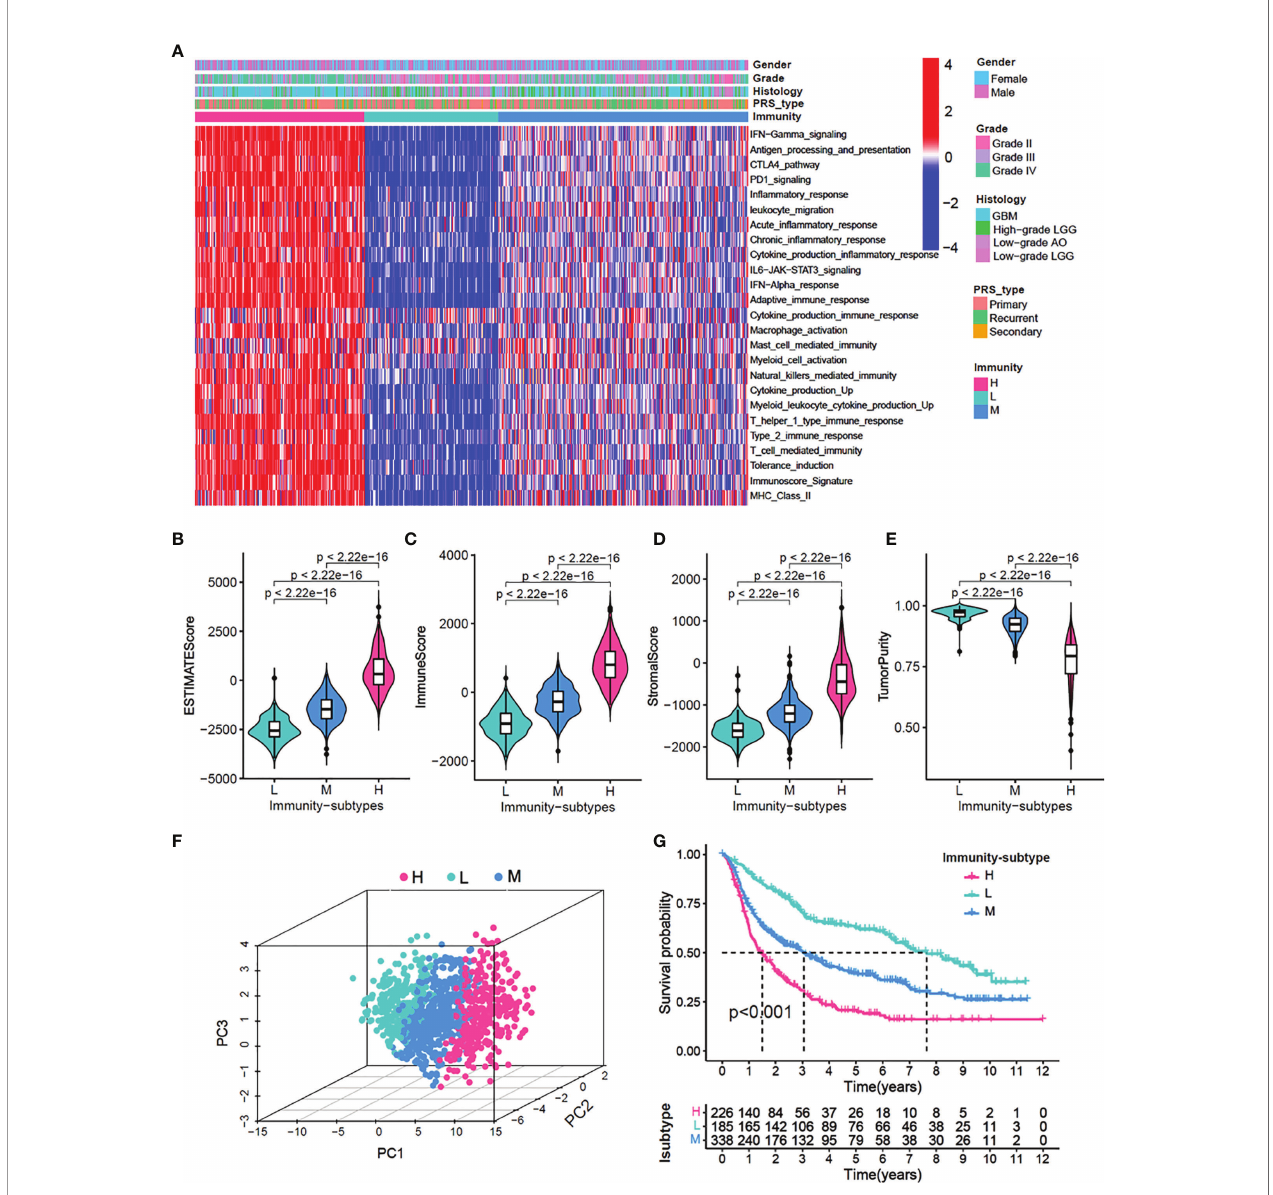
FIGURE 1 | Identi fi cation of three immunity-subgroups base on 25 immunity-related gene sets. (A) The heatmap showing the glioma samples divided into three distinct sub-group based on the GSVA enrichment scores of 25 immunity-related gene sets. Three subgroups de fi ned as immunity-H, immunity-M and immunity-L. Color bars at the top of the graph labels, the gender, grade, histology, PRS type. (B – E) Comparison of stromal scores (B) , immune scores (C) , estimated scores (D) , tumor purity (E) among three immunity-subgroups. (F) PCA analyses for three immunity-subgroups depicted by the dot in different colors. immunity-H, pink, immunity-M, blue; immunity-L, aquamarine. (G) OS Kaplan-Meier survival analysis among three immunity-subgroups (Log-rank